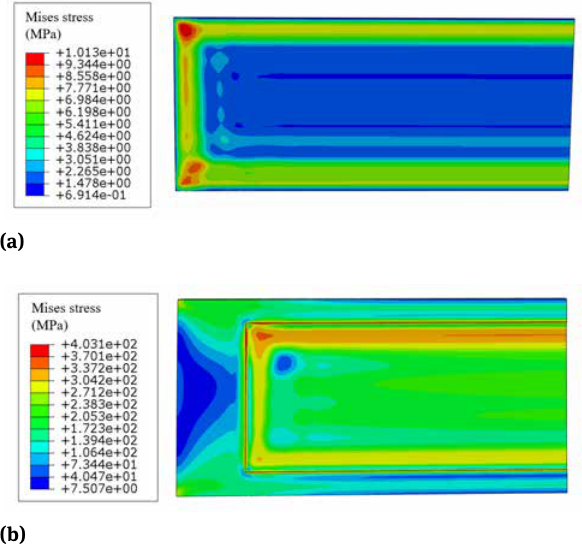
Figure 18: The contour plots of the Mises stresses (a) in the fuel meat and (b) the cladding